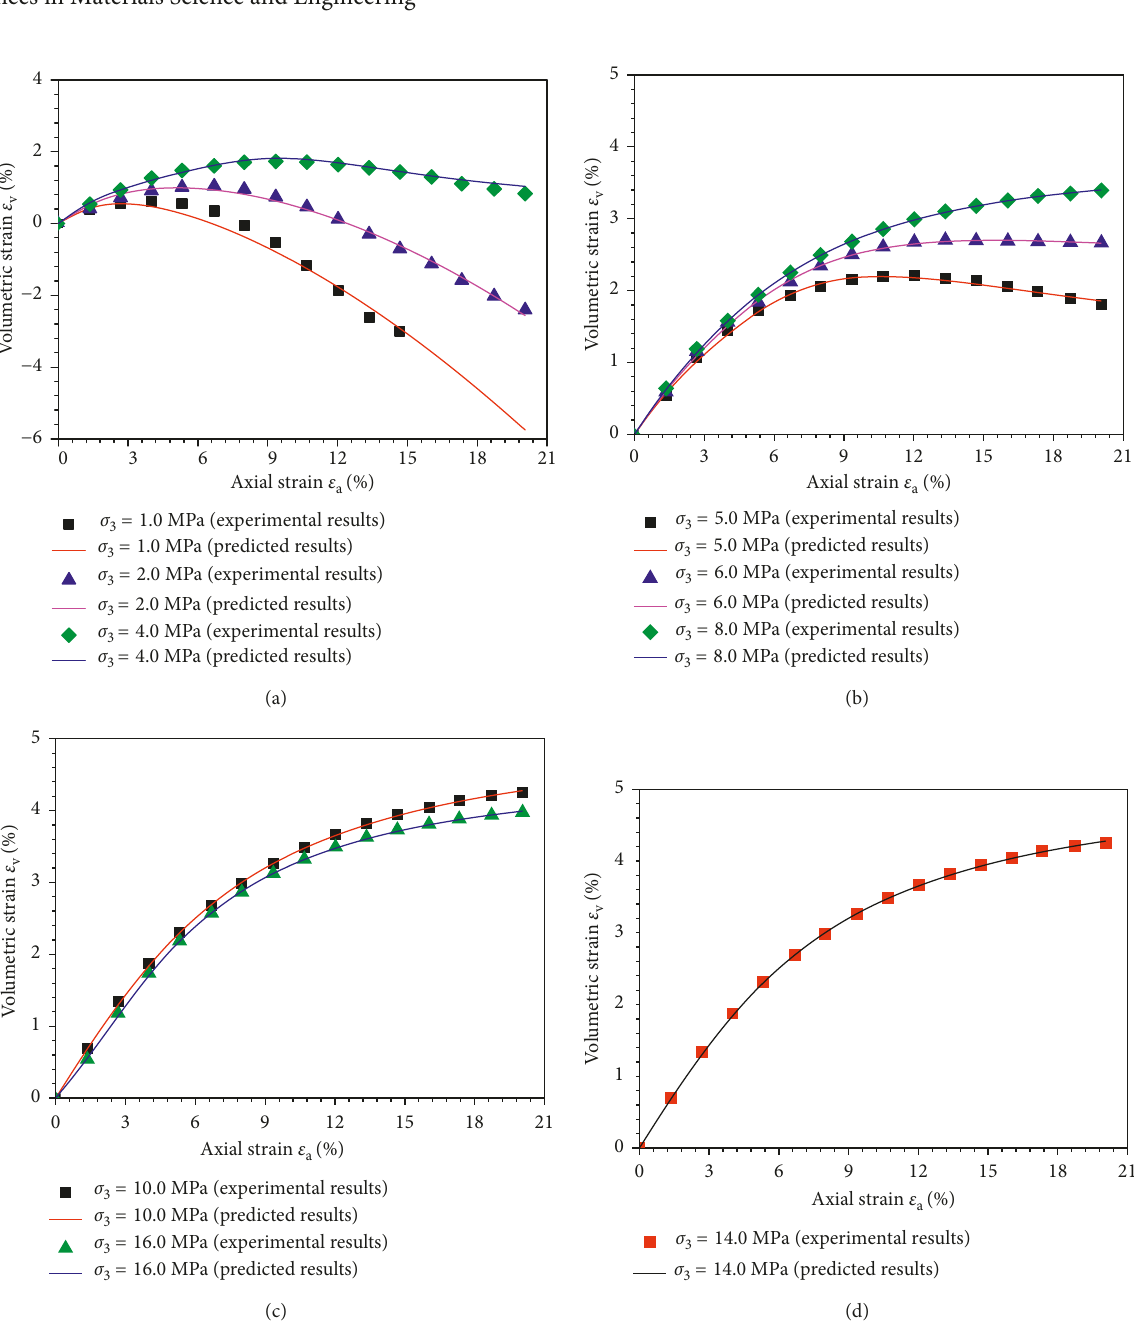
(2) The microstrength of frozen sandy soils obeys the Weibull distribution function. The strength cri- terion, which contains the damage properties of microstrength, is chosen as an independent variable in damage variable D . The parameters related to the damage statistical constitutive model are determined by experimental data, and they can well simulate both the curves of deviatoric stress-axial strain and volu- metric strain-axial strain.